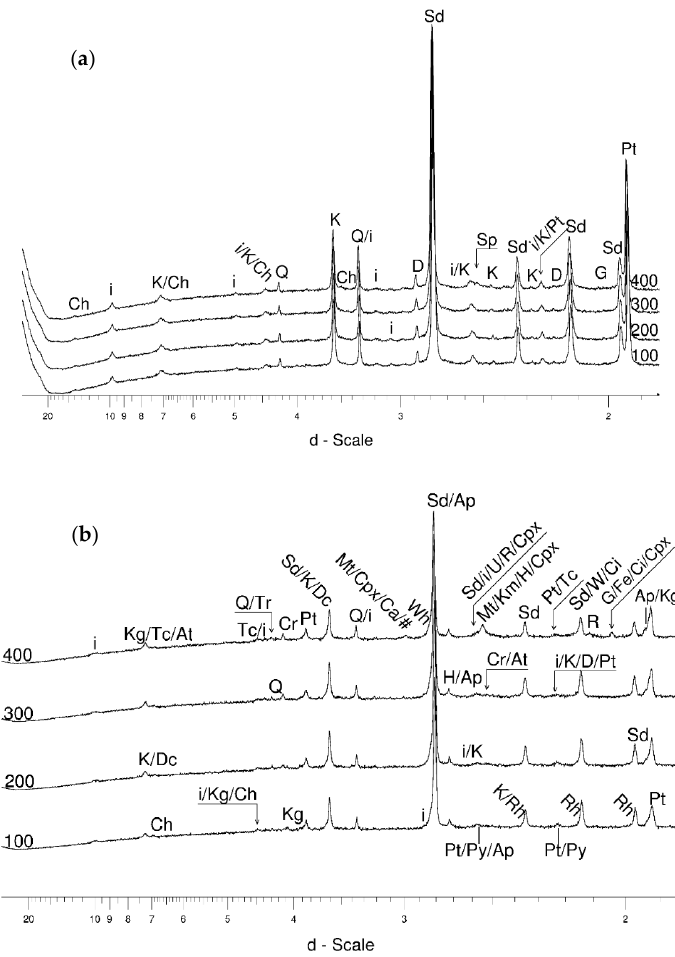
Figure 1. Results of heating (100–400 ◦ C) two sideritic samples for